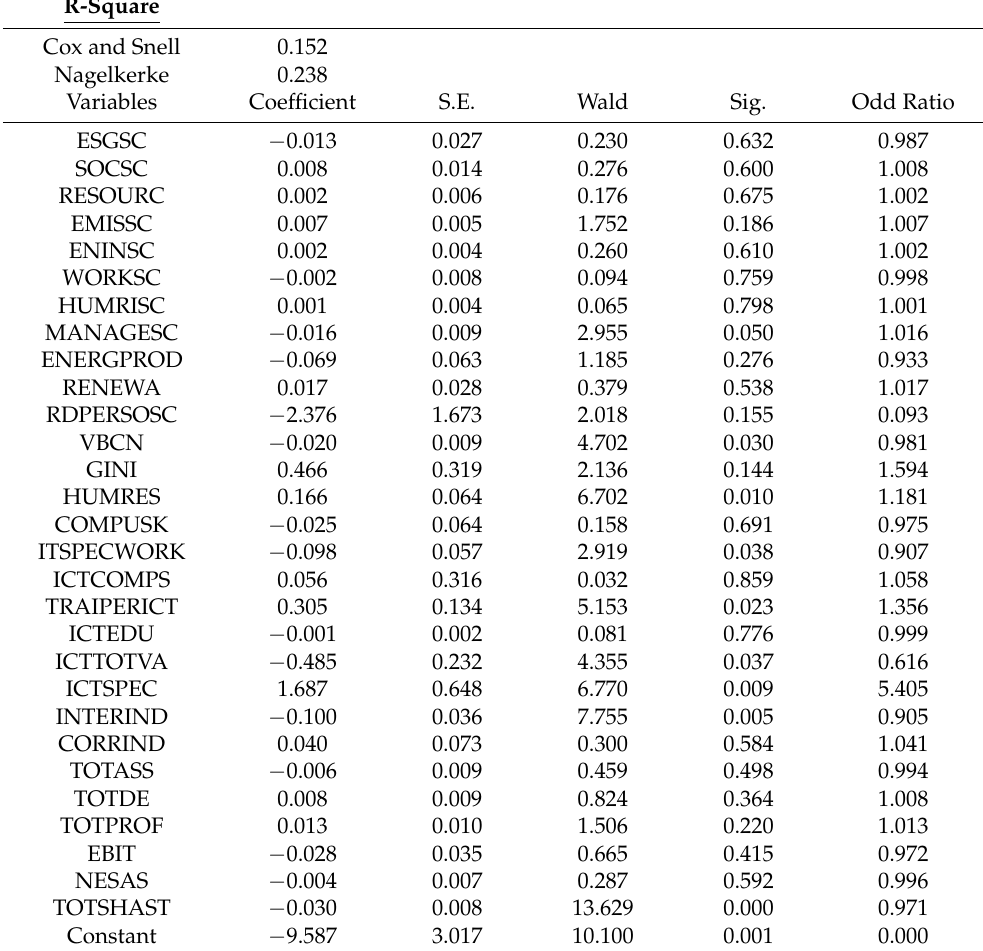
Table 6. Binary logit regression